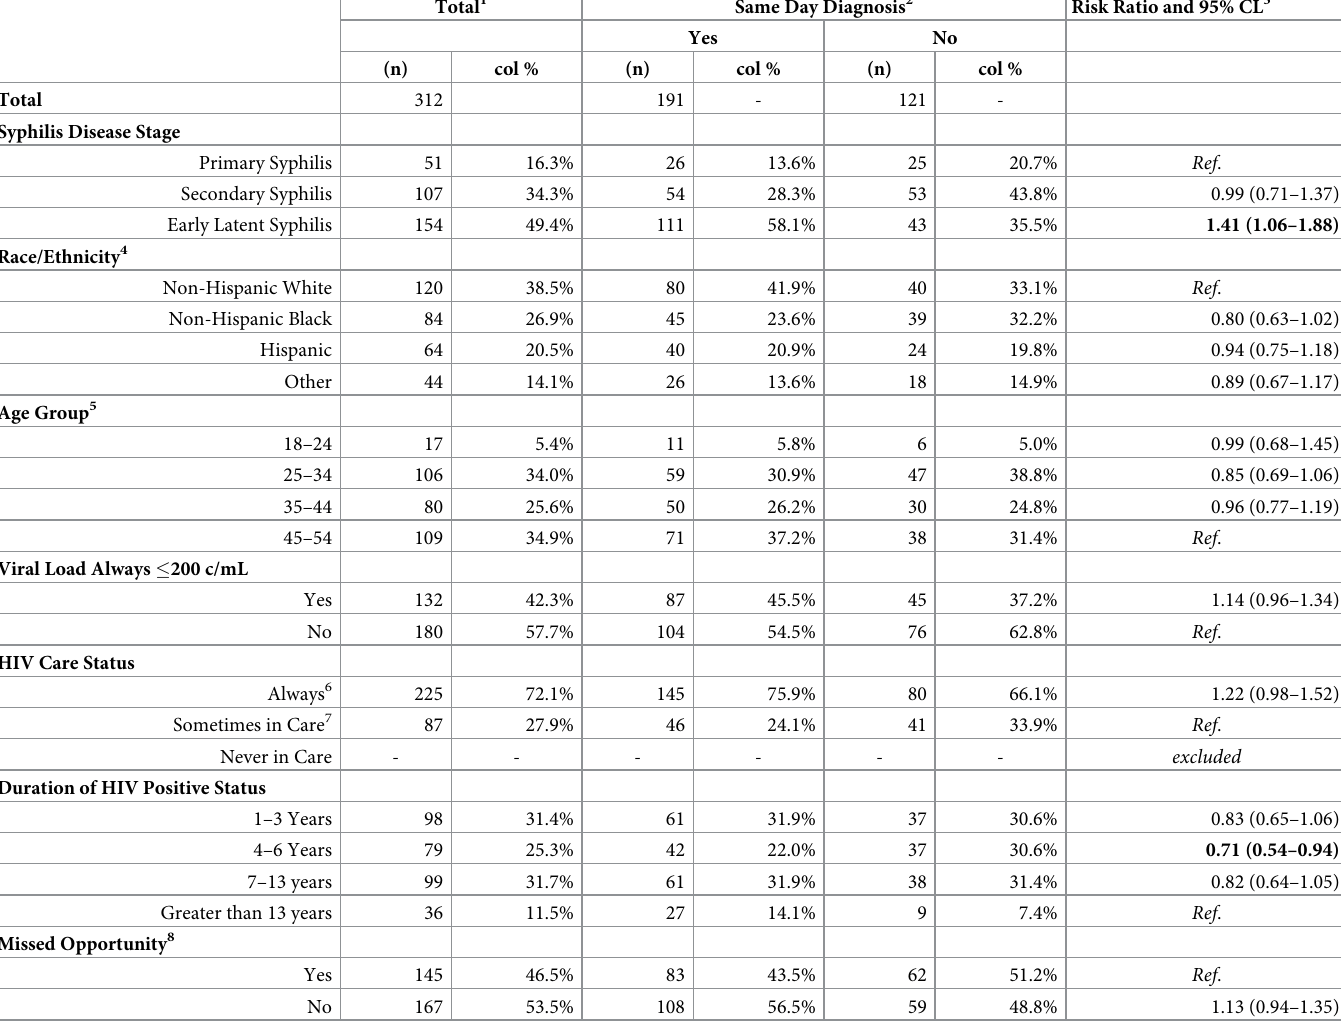
Table 3. Syphilis diagnosis on the same day as HIV care among MSM over the age of 18 living with HIV by demographic factors, New York state excluding New York city,